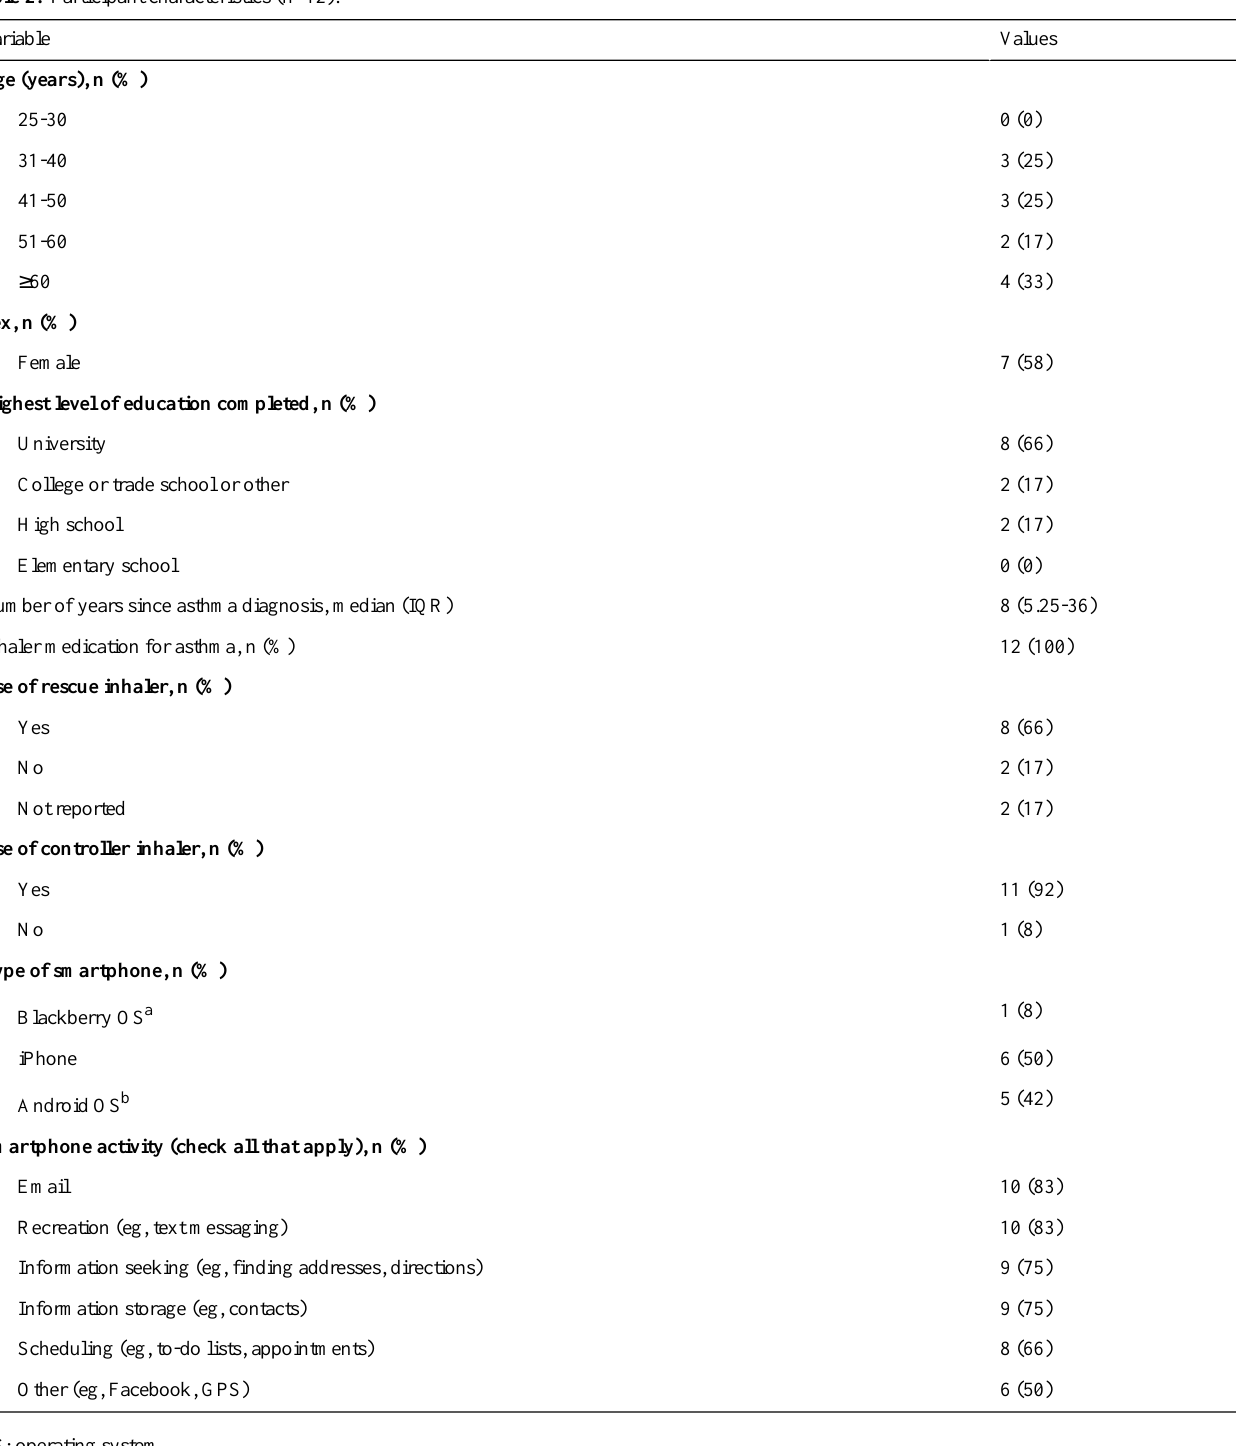
Table 2. Participant characteristics